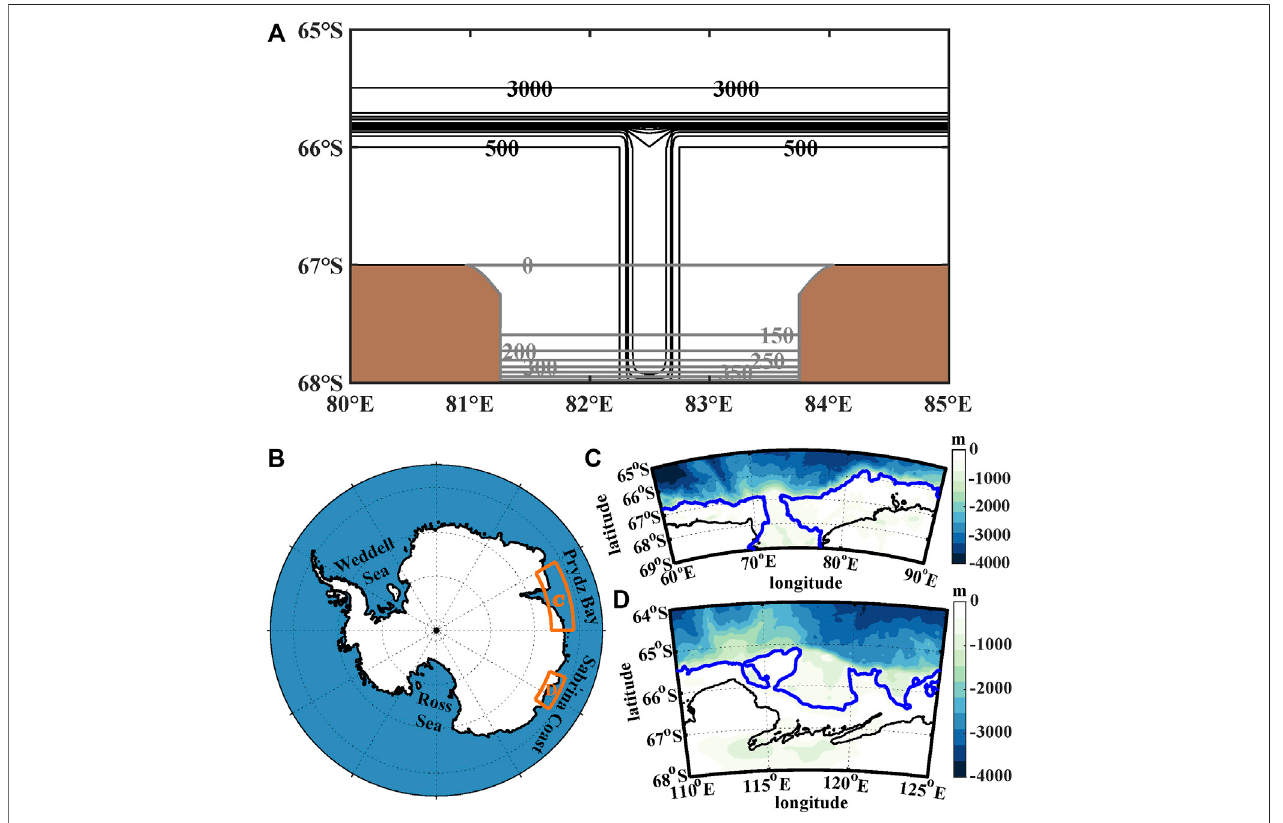
FIGURE 1 | (A) Topographical features of the idealized coupled ocean-ice shelf model. The black lines are the sea fl oor depth (at 50 m intervals from 500 to 1,000 m, and 500 m intervals from 1,000 m to3,000 m), and thegrey lines aretheice shelf draft in contour intervals of50 m. (B) The orangeboxes in themap show the typical Fresh Shelf regions around East Antarctica, corresponding to (C) and (D) , respectively. (C) The topography (m) in Prydz Bay, with the coastal line (black line) and the 500 m isobath (blue line). (D) Same as (C) , but for the Sabrina